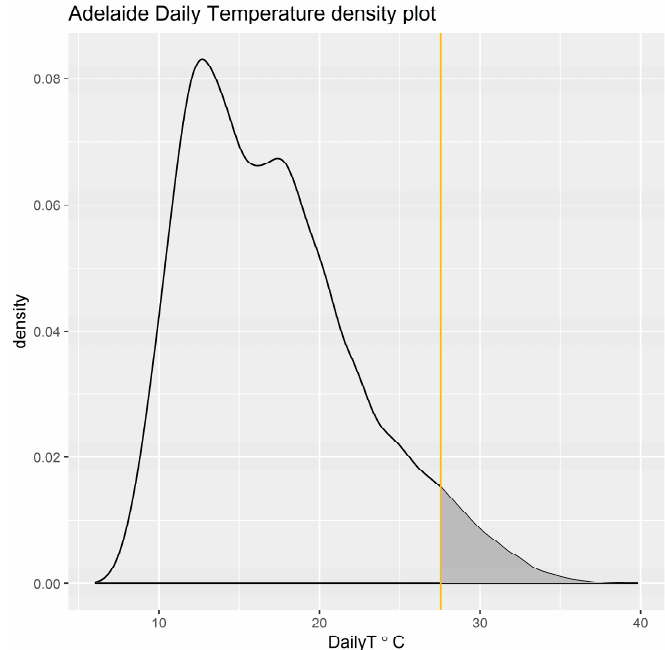
Figure A2. Distribution function of daily temperature for all days in 1971 to 2000 climate reference period. Grey shade shows 95th percentile tail for all heatwaves present for this reference period.